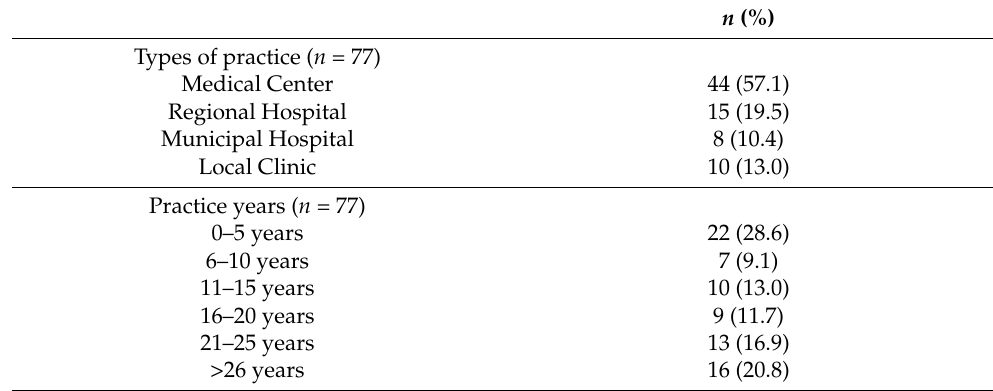
Table 2. Respondent